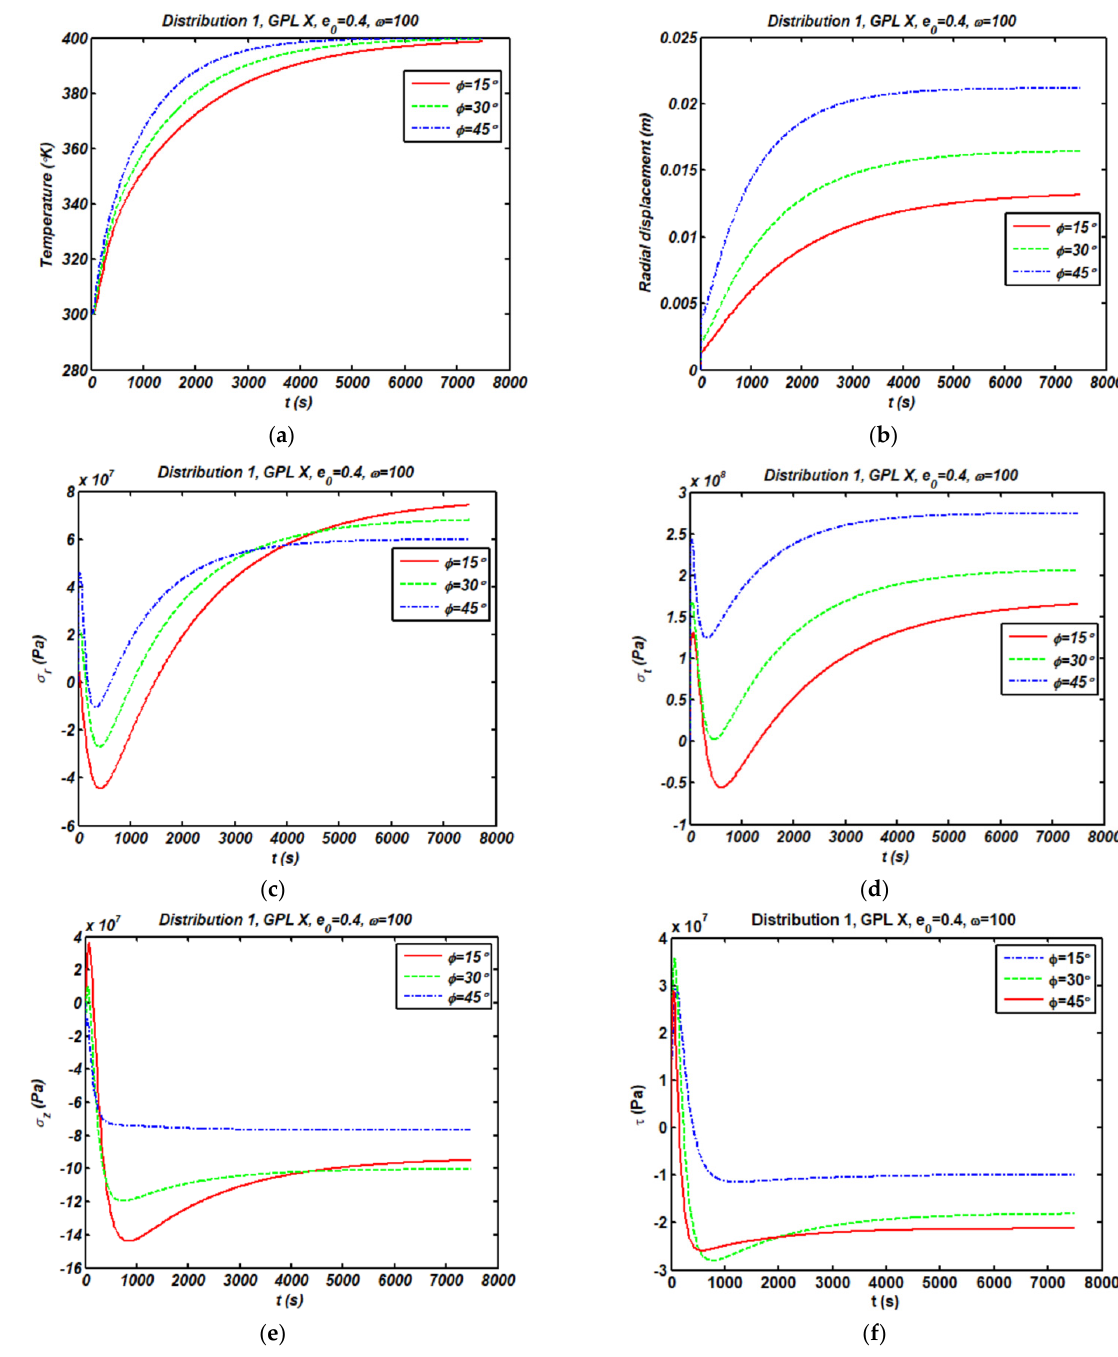
Figure 4. Influence of porosity distribution on the transient temperature ( a ), radial displacement ( b ), and stress state ( c – f ) for center point of truncated cone (GPL V; 0 e = 0.4; ω = 100 rad/s).